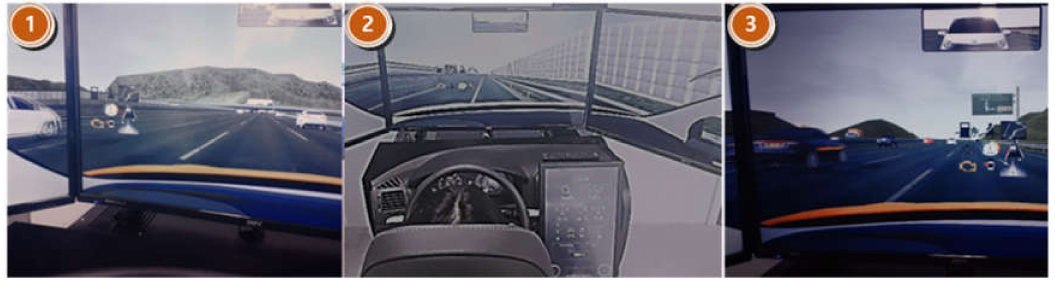
Figure 4. Classification for areas of head-up display (HUD).